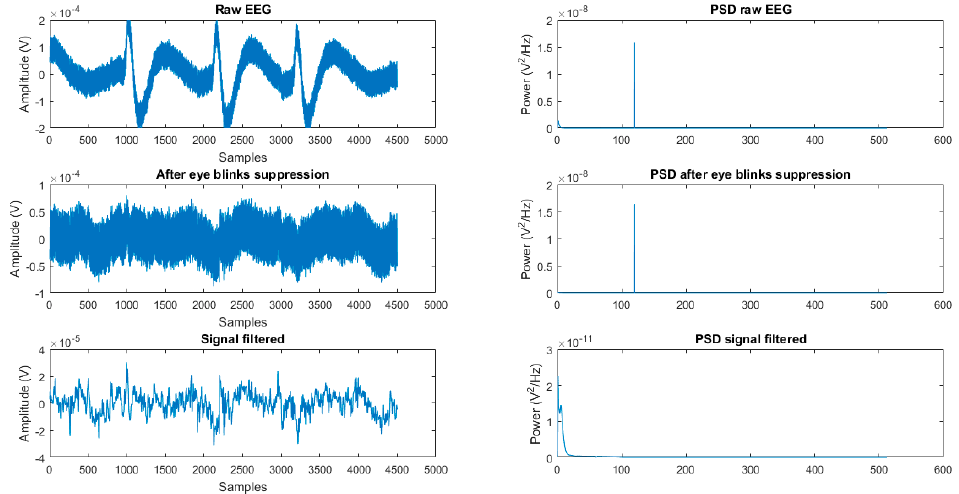
Figure 2. Results of the pre-processing stage in the signal and its respective PSD.